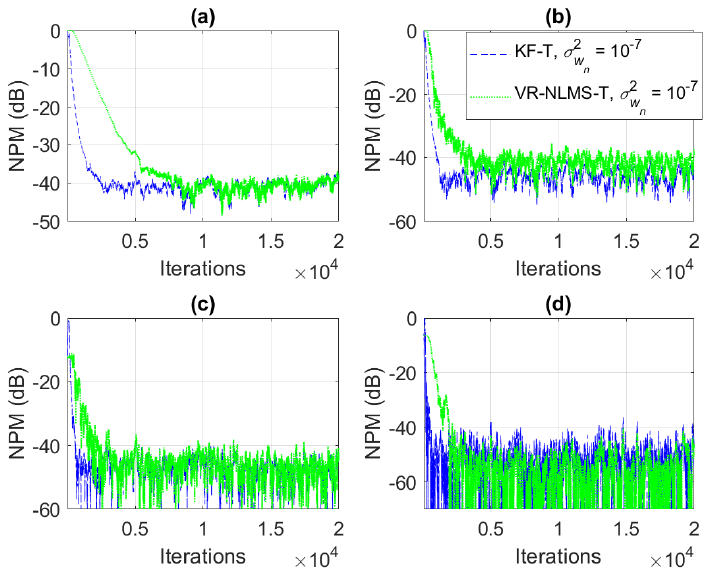
Figure 7. Normalized projection misalignment (NPM) of the KF-T and VR-NLMS-T algorithm = 10 − 7 , n = 1,2, . . . , N , for the identification of the individual impulse responses, using σ 2 w n (cid:104) (cid:105) (cid:104) (cid:105) (cid:104) (cid:105) h n ( t ) , n = 1,2, . . . , n . ( a ) NPM h 1 ( t ) , (cid:98) h 1 ( t ) h 2 ( t ) , (cid:98) h 2 ( t ) h 3 ( t ) , (cid:98) h 3 ( t ) , ( b ) NPM , ( c ) NPM , (cid:104) (cid:105) h 4 ( t ) , (cid:98) h 4 ( t ) and ( d ) NPM